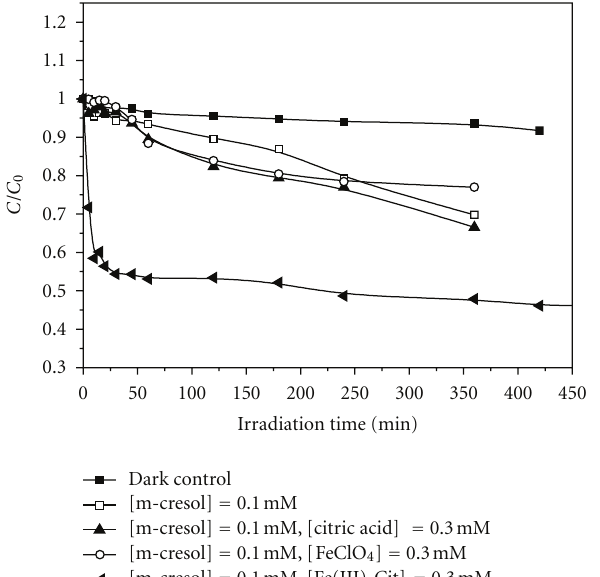
Figure 10: Fe(II) formation in the mixture m-cresol/Fe(III)-Cit (0.1mM, 0.3 mM) upon irradiation at λ irradiation = 365nm (cid:5) pH = Figure 8: Photodegradation of m-cresol (0.1mM) in di ff erent systems upon irradiation at λ irradiation = 365 nm: (cid:2) m-cresol only; (cid:4) m-cresol/Fe(III)-Cit (cid:5) m-cresol-citric acid; (cid:3) m-cresol-FeClO 4 ; complex.